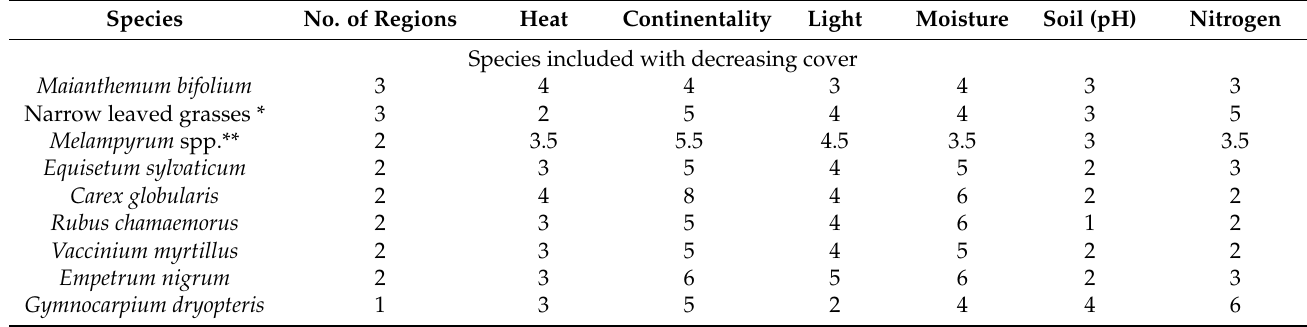
Table A2. Individual and mean EIV for species showing decreasing cover in this study and mean value for all other species included in the Swedish NFI. No. of regions indicates the number of regions where the species significantly decreased in